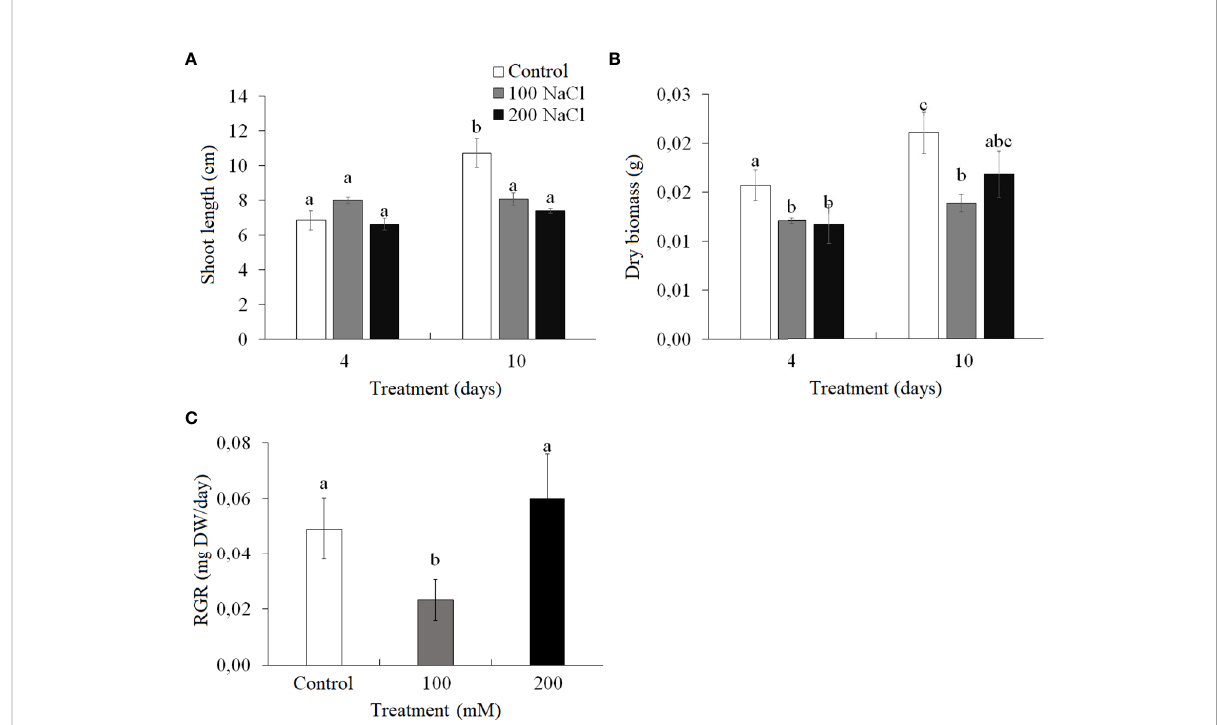
FIGURE 1 Effect of 4- and 10-day treatments with low (100 mM NaCl) and moderate (200 mM NaCl) salinity on plant biomass of Kochia prostrata . (A) Shoot length. (B) Dry biomass. (C) Relative growth rate (RGR) between fourth and 10th days NaCl treatment. Values are means ± standard errors of one experiment with three biological replicates. The different letters show statistically different means at P ≤ 0.05 (Tukey